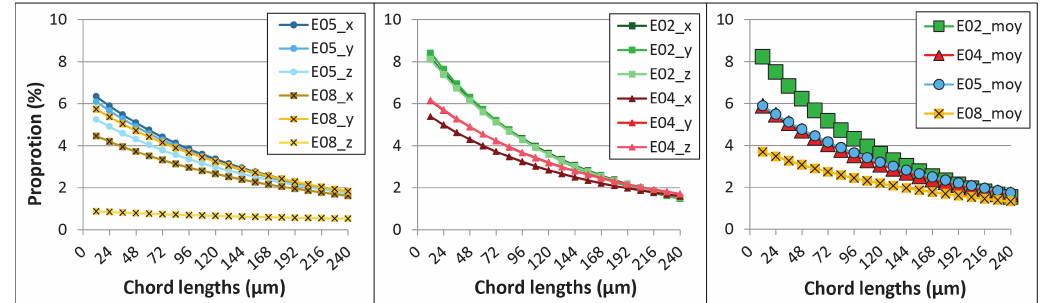
Figure 7. Chords length distribution for Euville samples, pore diameters are displayed by proportion. On the left, an average of chord lenghts in the three directions is shown. On the middle and right, chord lengths are detailed in directions X, Y and Z: E02 and E04 on the middle and E05 and E08 on the